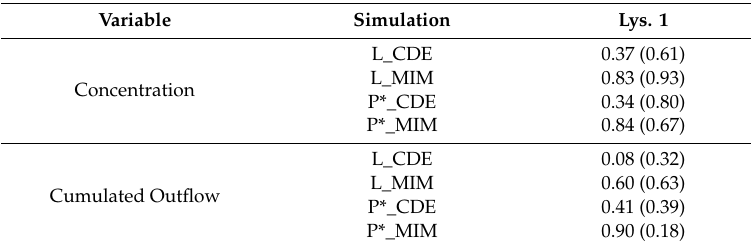
Figure 7. Comparison between experimental and simulated bromide concentration and cumulative outflow as a function of cumulative drainage (( a ); ( c )) and time (( b ); ( d )) on Lys. 1. L_CDE for results obtained with the convection-dispersion equation and parameters optimized with HYDRUS-1D on lysimeter data; L_MIM for results obtained with the mobile-immobile model and parameters optimized with HYDRUS-1D on lysimeter data; P*_CDE for results obtained with the convection-dispersion equation and by applying the mean optimized parameters from the 165 cm deep profiles of the three field plots; P*_MIM for the results obtained with the mobile-immobile model and by applying the mean optimized parameters from the 165 cm deep profiles of the three field plots. Results obtained with oP* are not shown since the bromide concentration dynamics found as a function of cumulative drainage and time were similar to P*. Table9. E ffi ciencycoe ffi cientscalculatedforbromideconcentrationandcumulatedoutflow asafunction of time (and cumulative drainage in parentheses) from Lys. 1 and based on di ff erent optimization procedures using